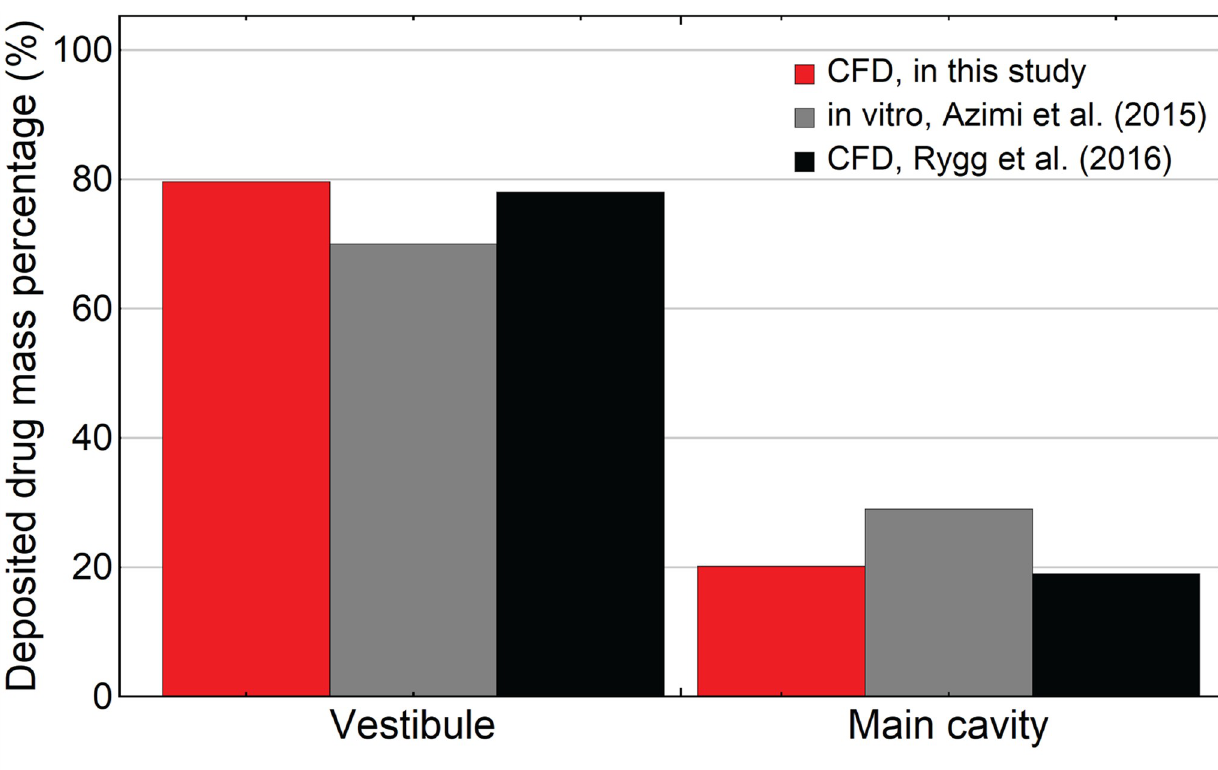
Fig 6. Regional particle depositions in the vestibule and main cavity and comparisons with reported in-vitro measurements from Azimi et al. [31] and reported CFD simulation results from Rygg and Longest [21].